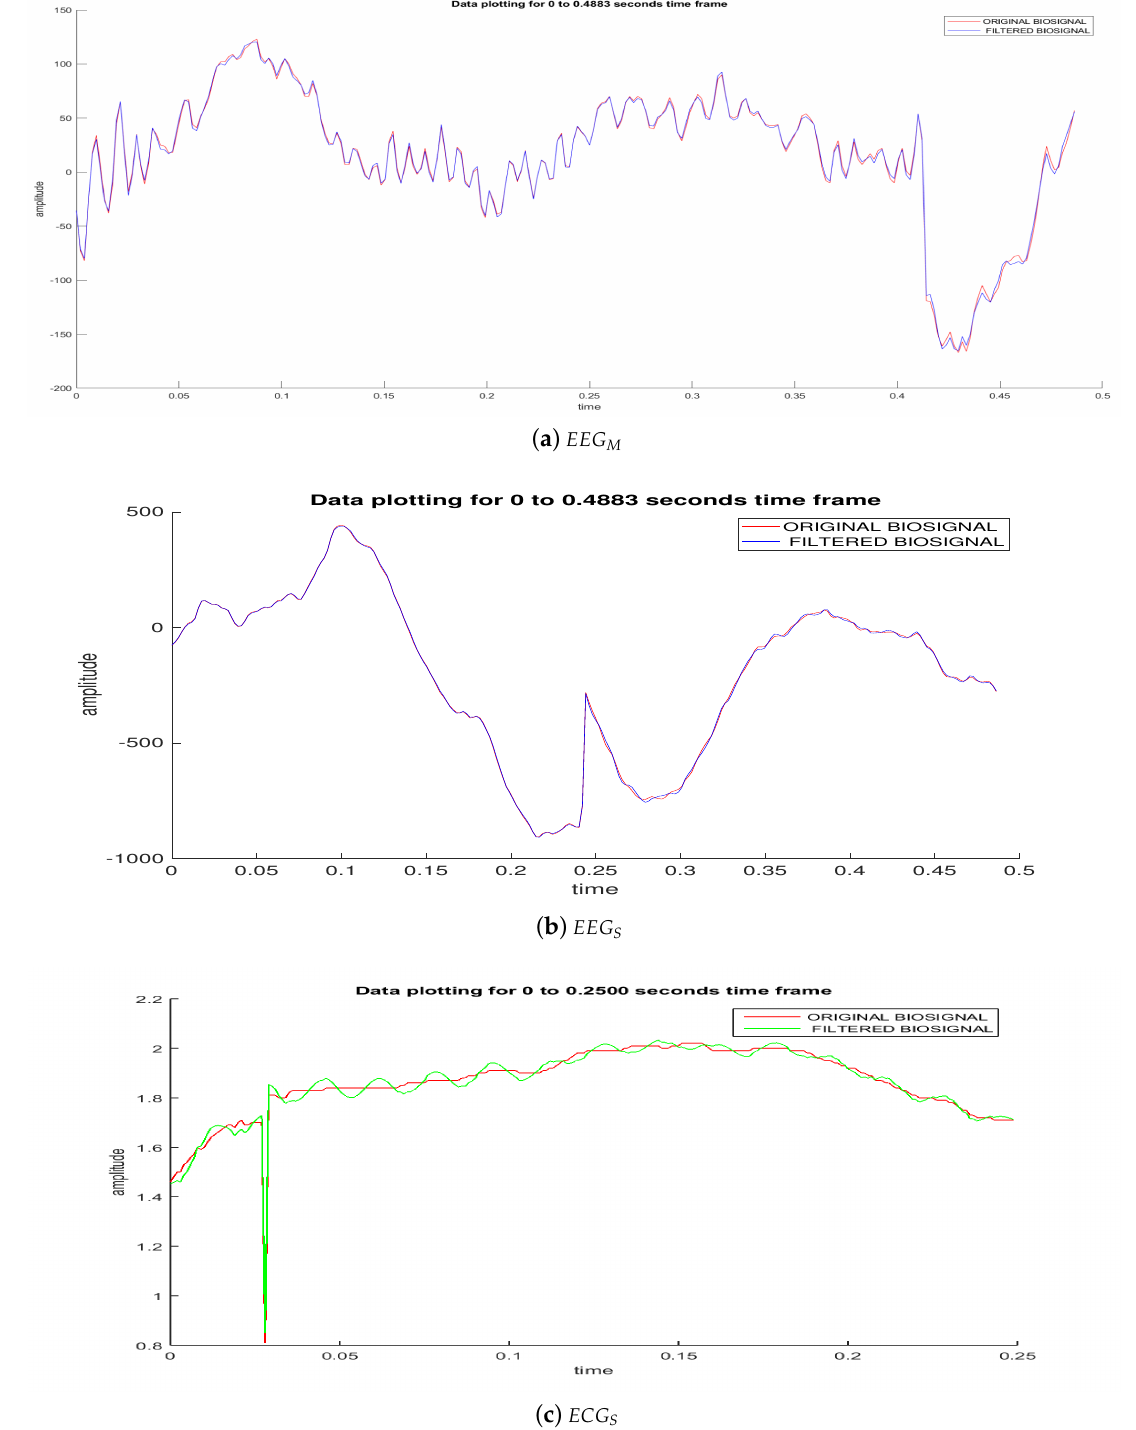
Figure 26. Analysis of biomedical signal interfaces: Notch